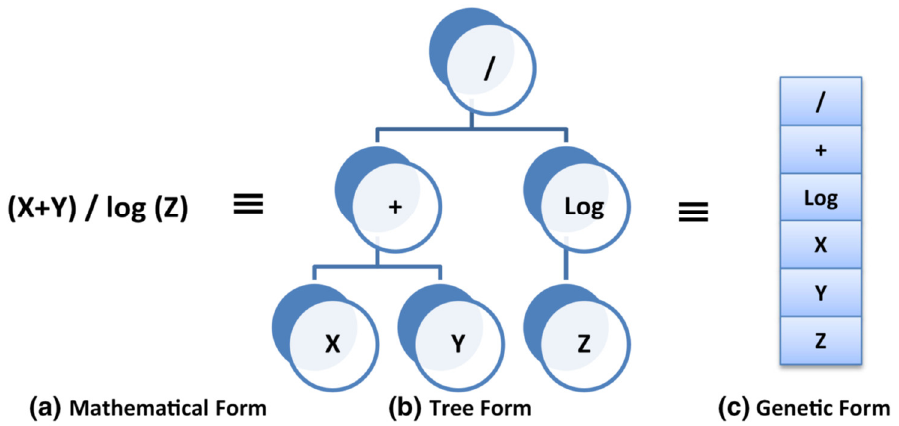
Figure 1. Traditional tree form and genetic representation of mathematical expressions [21].